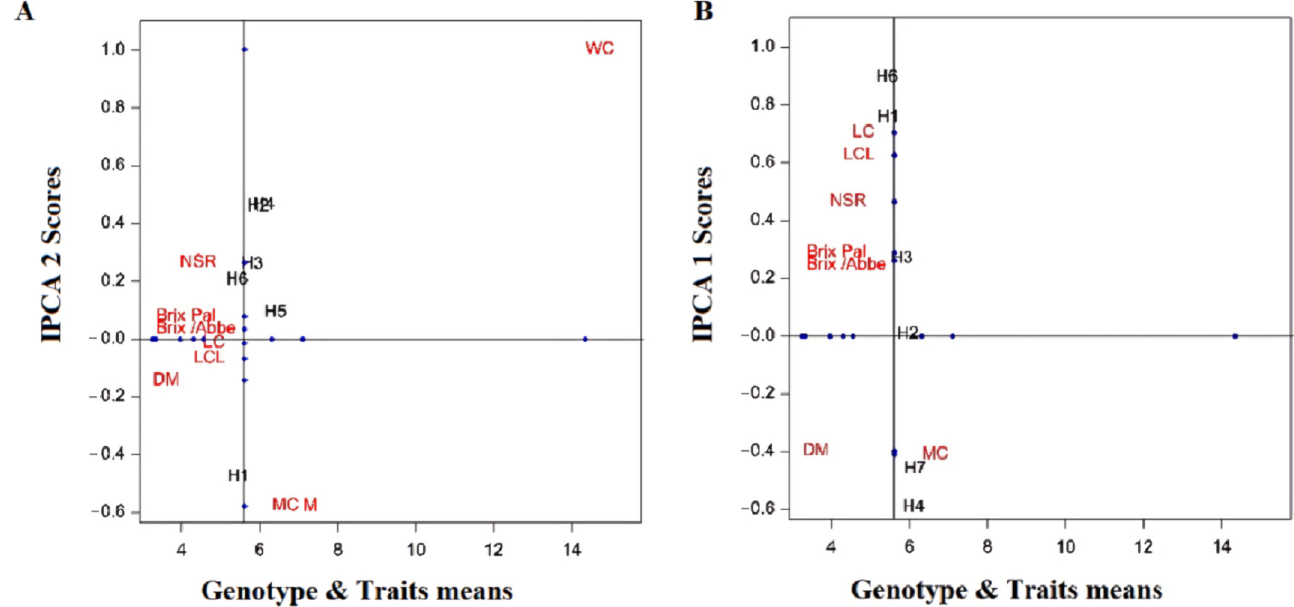
Figure 2. AMMI biplot on IPCA 2 (( A ) comparison based on the traits) and IPCA 1 (( B ) comparison based on the genotype) on different maize hybrids in non-irrigated and irrigated treatments. Ear length (LC), net ear length (LCL), ear weight (WC), number of kernel rows (NSR), Brix / Atago Pal-1, Brix / Abbe, soil moisture (M), dry matter content of cob (DM), moisture content of cob (MC). (H1: Noa, H2: Dessert R78, H3: Dessert R72, H4: Messenger, H5: SF1379, H6: Honey, H7: GSS5649).